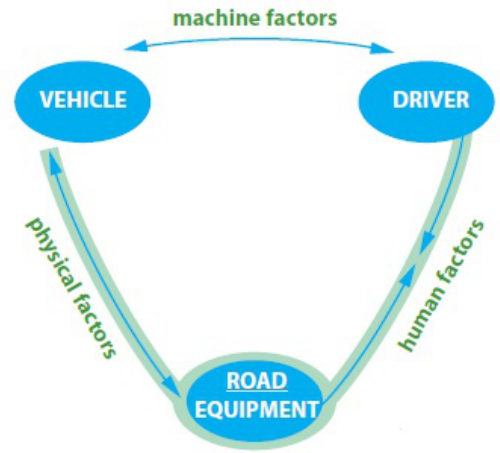
Figure 1. Elementary triangle of road